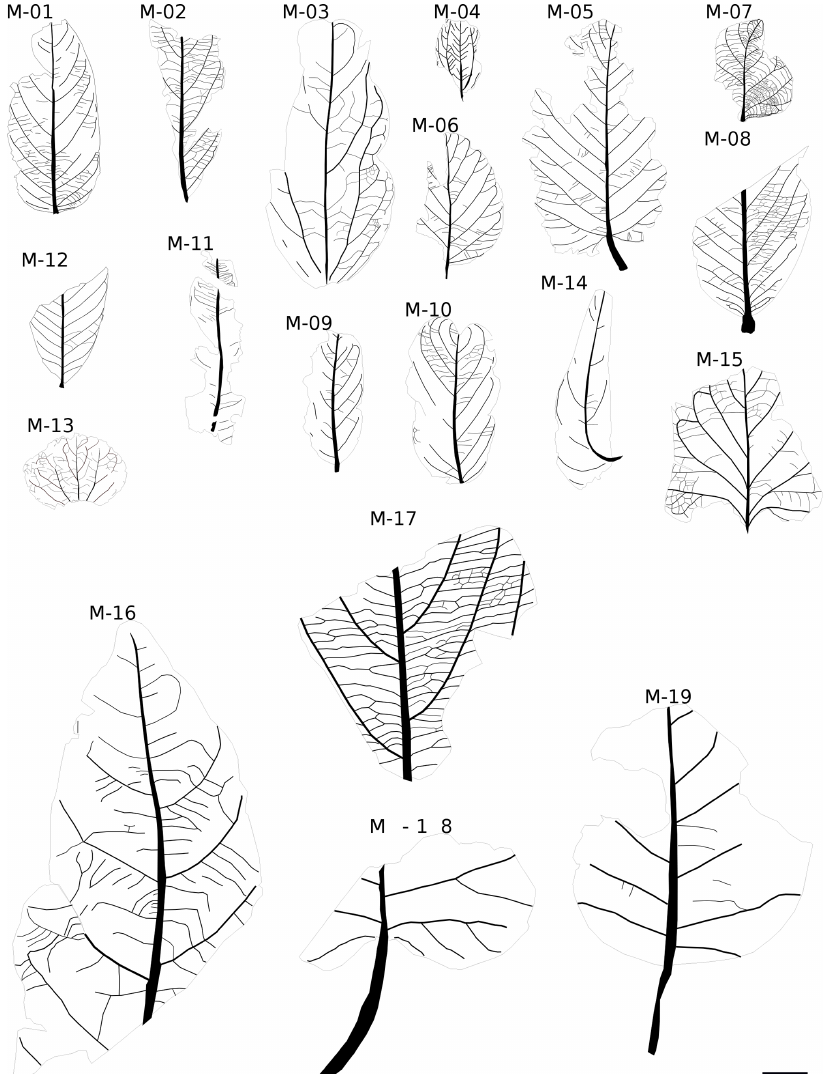
Figure 2. Line drawings of dicot (non-monocotyledonous angiosperm) leaf morphotypes, Baris, Egypt. The scale bar is 4cm.